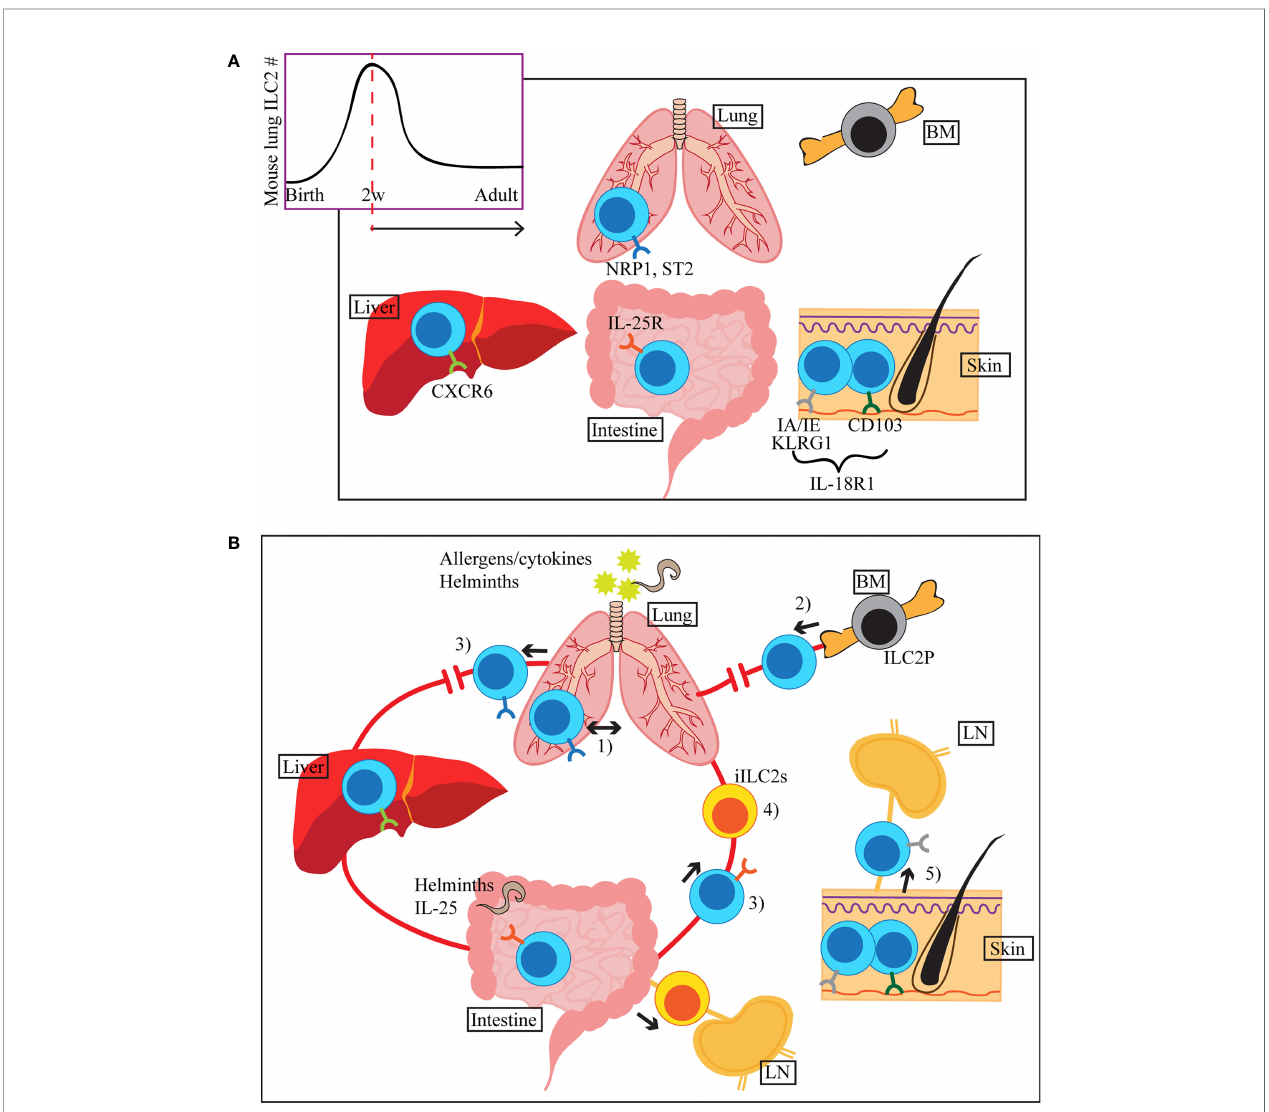
FIGURE 1 | (A) ILC2s seed tissues early during the neonatal period, with a peak of ILC2 accumulation around 2 weeks after birth (mouse lung). Once in tissues, they receive environmental cues and adapt tissue speci fi c phenotypes, indicated by different colours of the surface receptors in the fi gure. Common ILC2 markers in each tissue are shown, but they can also be expressed in other organs. (B) ILC2s migrate within the lung upon i.n. IL-33 or Aa treatment (1). During allergen-induced respiratory in fl ammation or tissue disruption, ILC2s are recruited from hematogenous sources (2). When activated by allergens/cytokines or helminth infection, some of the lung and small intestinal ILC2s appear in the peripheral blood (3). Stimulation by i.n. IL-33 or papain induces migration of a subset of lung ILC2s to the liver, where they contribute to the regulation of local immunity (3). Upon helminth infection or i.p. IL-25 stimulation, small intestine-derived in fl ammatory ILC2s (iILC2s) appear in circulation and accumulate in the lung, liver, mesenteric LN and spleen (4). iILC2s ultimately become conventional ILC2s in the lung. Tissue resident and circulating ILC2s are present in the skin. During atopic dermatitis-like in fl ammation, circulatory ILC2s migrate to the draining LN